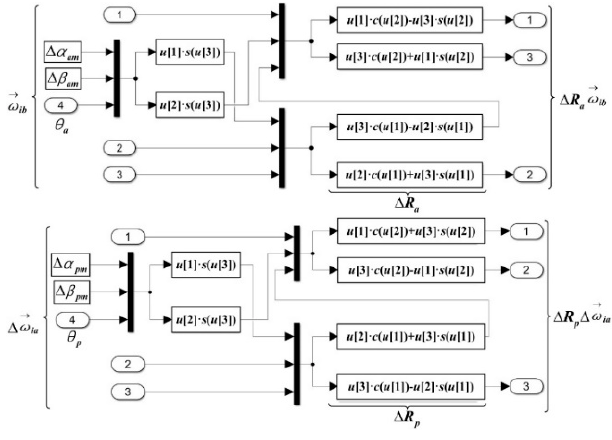
Figure 12. The signals affected by errors of run-outs.